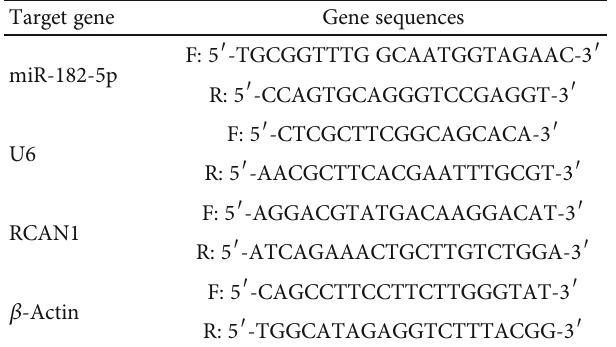
Table 1: Primer sequences in